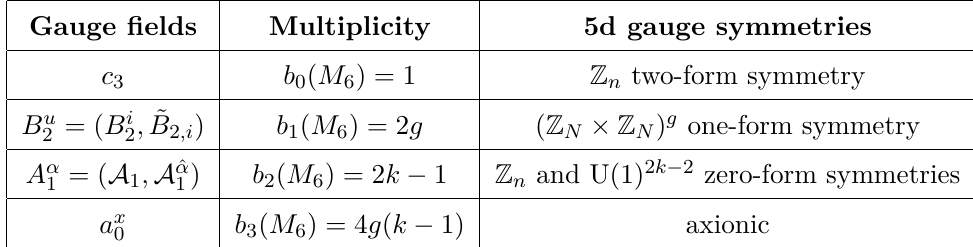
Table 2 . Summary of the 5d p -form gauge fields and symmetry groups arising from cohomology classes of the internal space M 6 . Recall that n ≡ gcd ( N α )